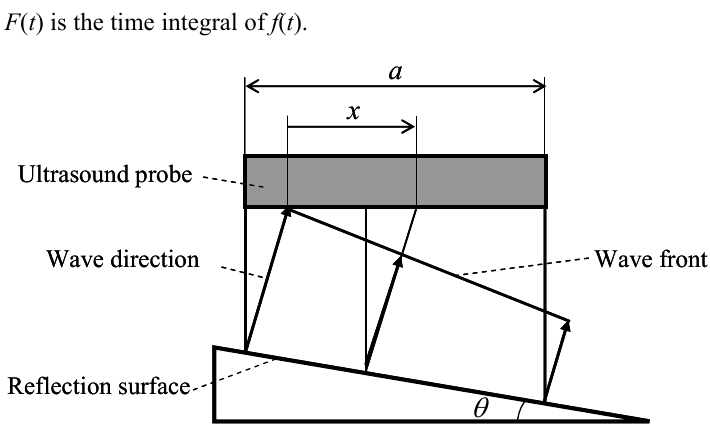
where F ( t ) is the time integral of f ( t ).